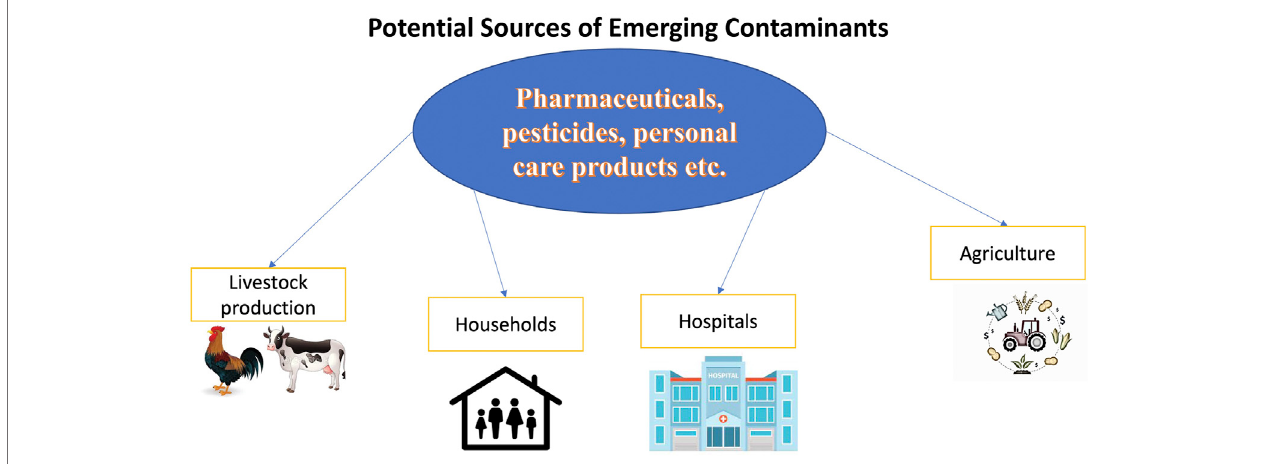
FIGURE 1 | Routes for EC spreading in the